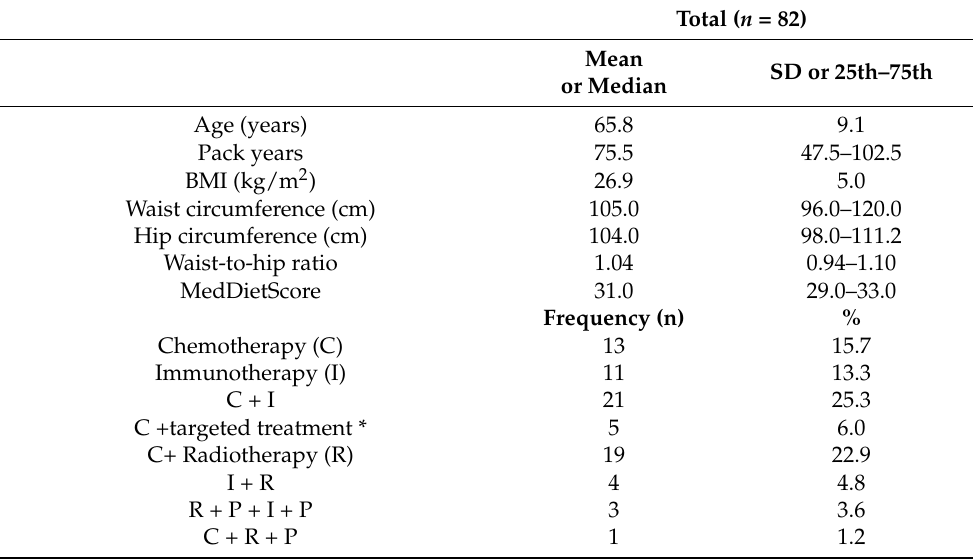
Table 1. Basic characteristics of participants and lines of